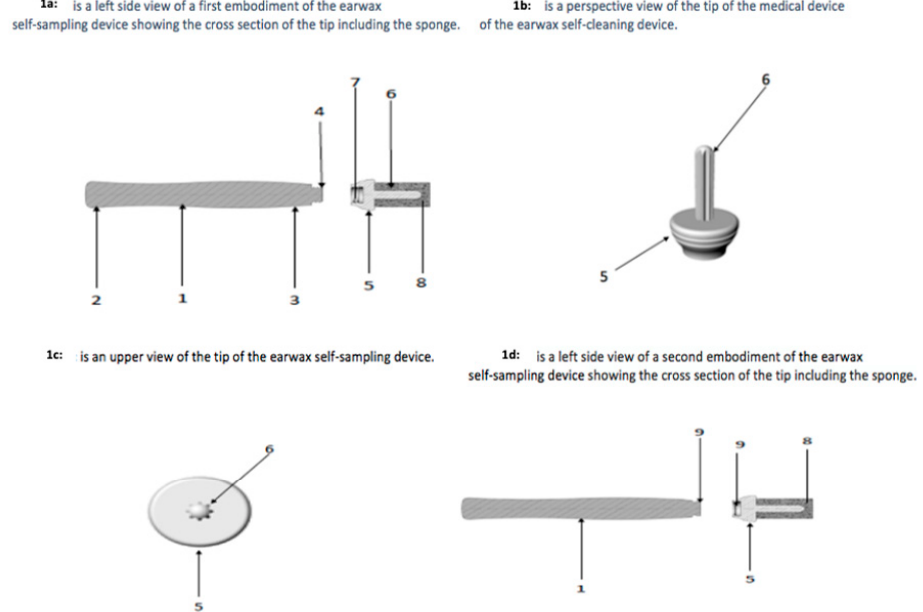
Figure 1. A detailed diagram of the earwax self-sampling device.